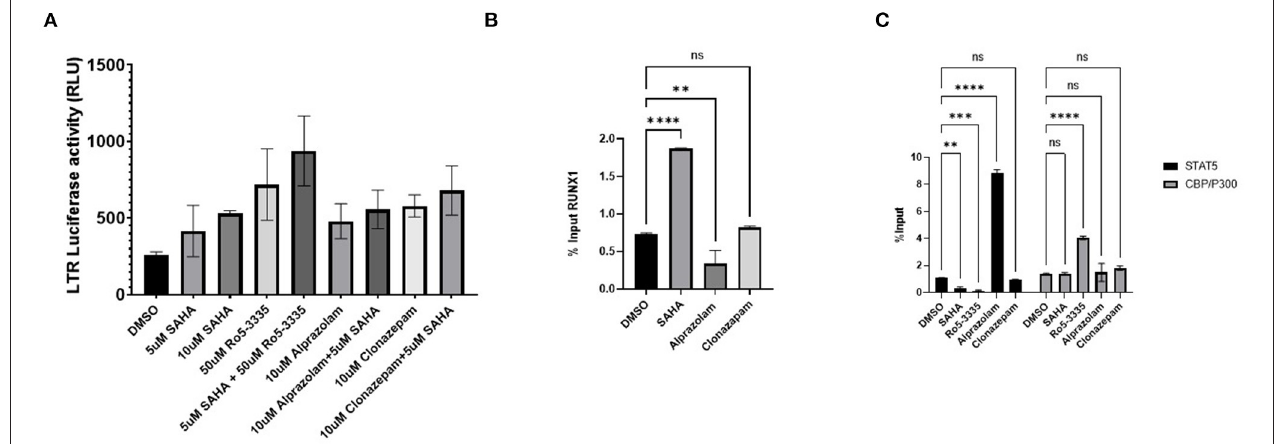
FIGURE 4 | Recruitment of STAT5 and CBP/P300 to the LTR by benzodiazepines in TZMBL Cells. TZMBL cells were treated with Benzodiazepines: RO5-3335, Alprazolam and Clonazepam with or without HDACi SAHA for 48 hrs at the indicated concentrations. (A) Cells were lysed and LTR driven luciferase was determined. (B) ChIP analysis was performed to determine RUNX1 binding to the HIV-1 LTR. (C) ChIP analysis was performed to determine STAT5 and CBP/P300 binding to the HIV-1 LTR. ** P ≤ 0.01, *** P ≤ 0.001, **** P ≤ 0.0001, ns = not significant.